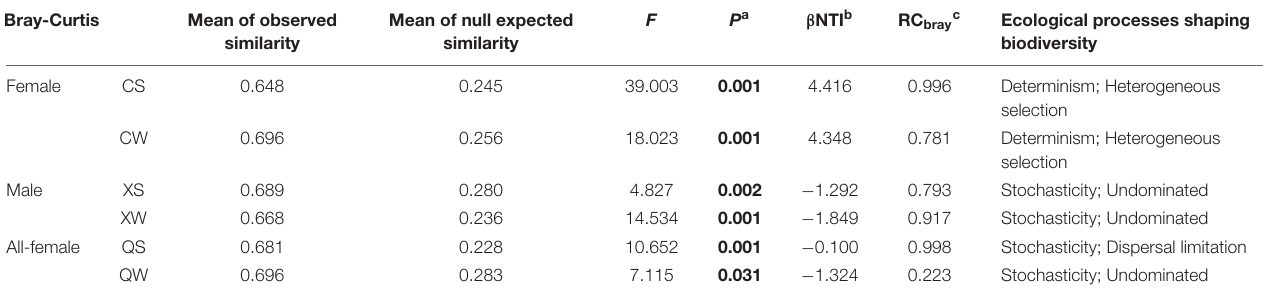
TABLE 5 | Significance test of the similarity between the intestinal microbial communities of the yellow drums and null model simulations, and β NTI and RC Bray values based on weighted Bray-Curtis distances. Bray-Curtis Mean of observed